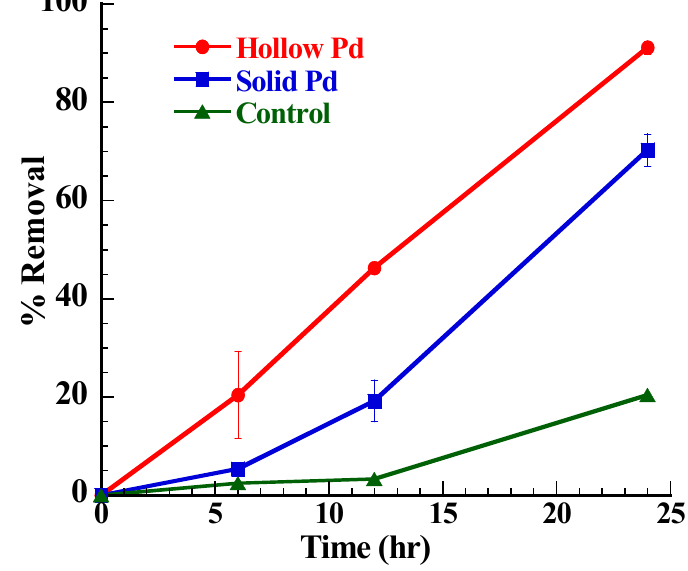
Figure 6. Plot of percent removal of MO dye in the solution with time by EABs in presence of solid or hollow Pd nanoparticles.